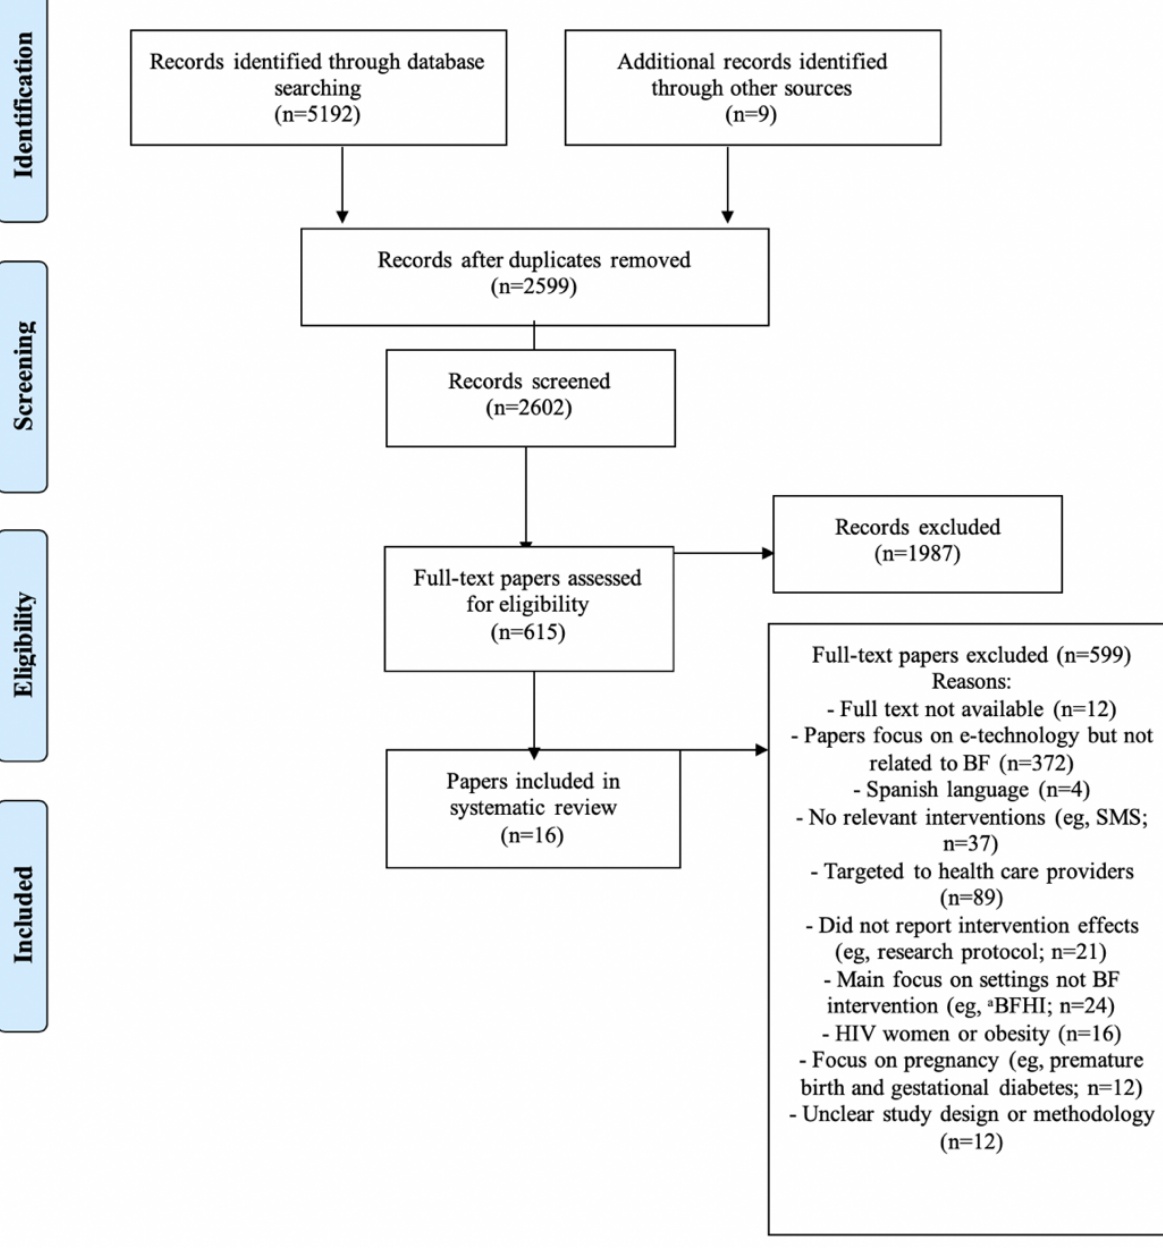
Figure 1. Flow Diagram of the systematic review - data extraction (BF, BSES). BF: breastfeeding; BHFI: baby friendly hospital